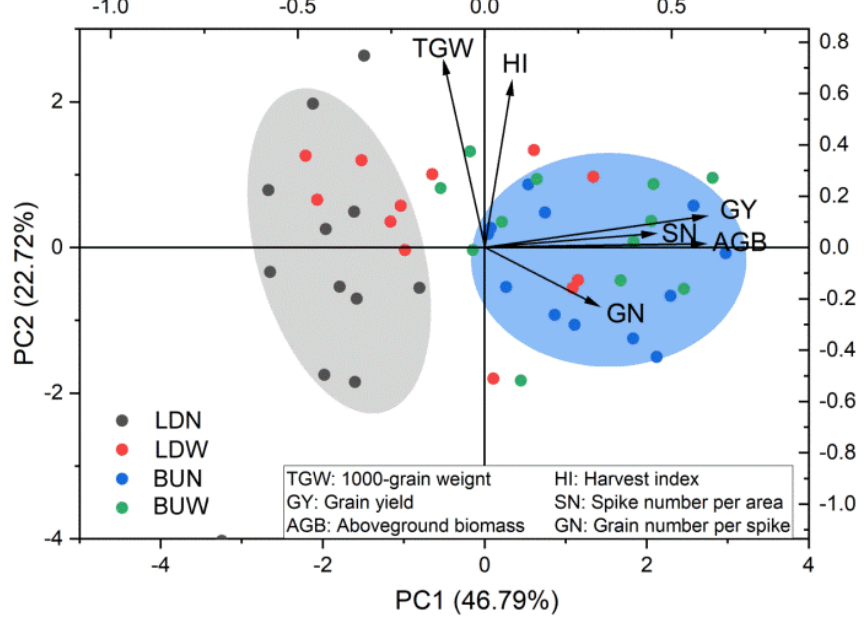
Figure 7. PCA based on yield formation and yield components of winter wheat grown under different sowing patterns during three consecutive growing seasons.